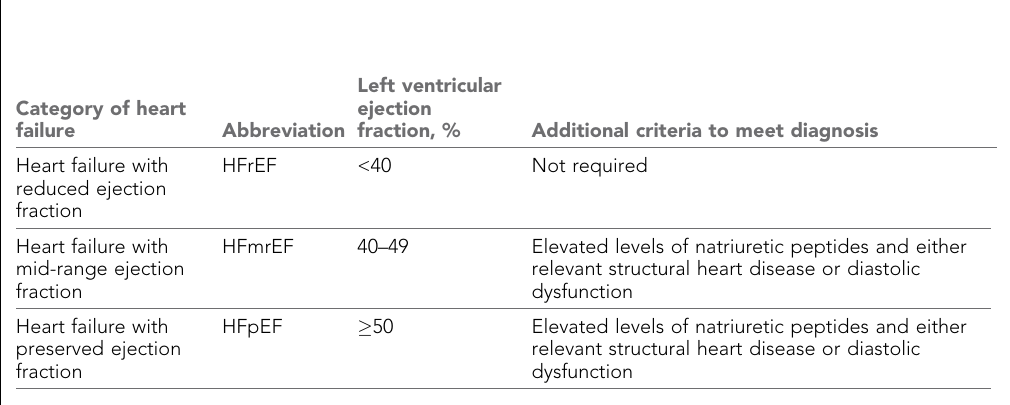
Box 1. European Society of Cardiology heart failure categories by ejection fraction